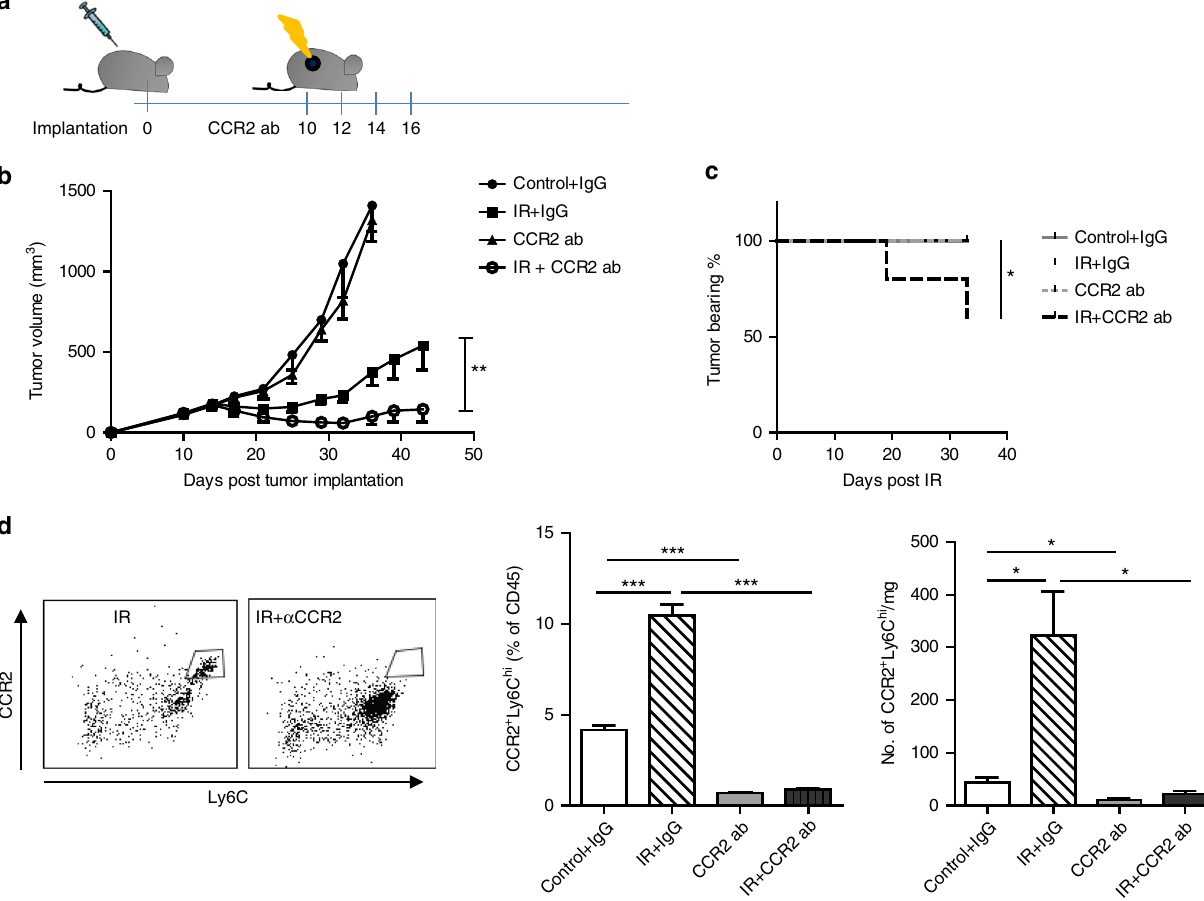
Fig. 3 Depletion of CCR2 cells enhances tumor radiosensitivity. a Scheme of treatment. b Treated tumor was measured every 3-4 days for 33 days starting from the day of radiation ( n = 10). c Percentage of mice still bearing tumor at the end of the treatments ( n = 10), P < 0.05. d Flow cytometry pro fi le of CCR2 + Ly6C hi in tumors 3 days post the start of treatments. Left, representative fl ow graph, gated on CD45 + CD11b + cells; Middle, percentage of CD45 + ; Right, absolute number of cells ( n = 4). NS, non-signi fi cant.* P < 0.05; ** P < 0.01; *** P < 0.001. Each experiment was repeated 3 times. Data are presented as mean ±